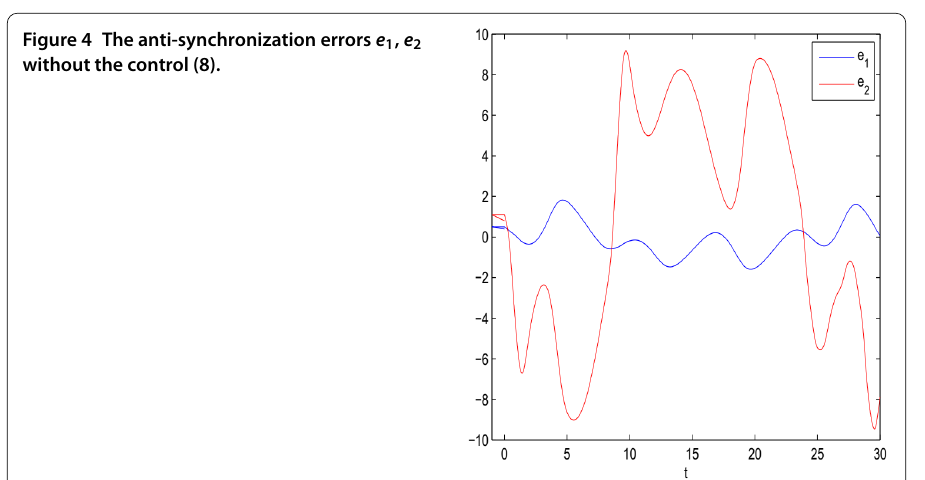
Figure 4 The anti-synchronization errors e 1 , e 2 without the control